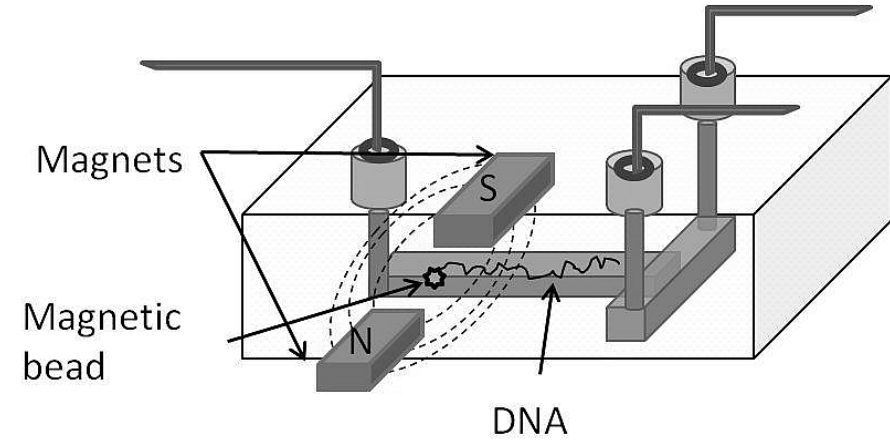
Figure 5. Schematic of DNA stretching by attaching a magnetic bead to one end of the DNA molecule while the other end is fixed onto the surface of the cover